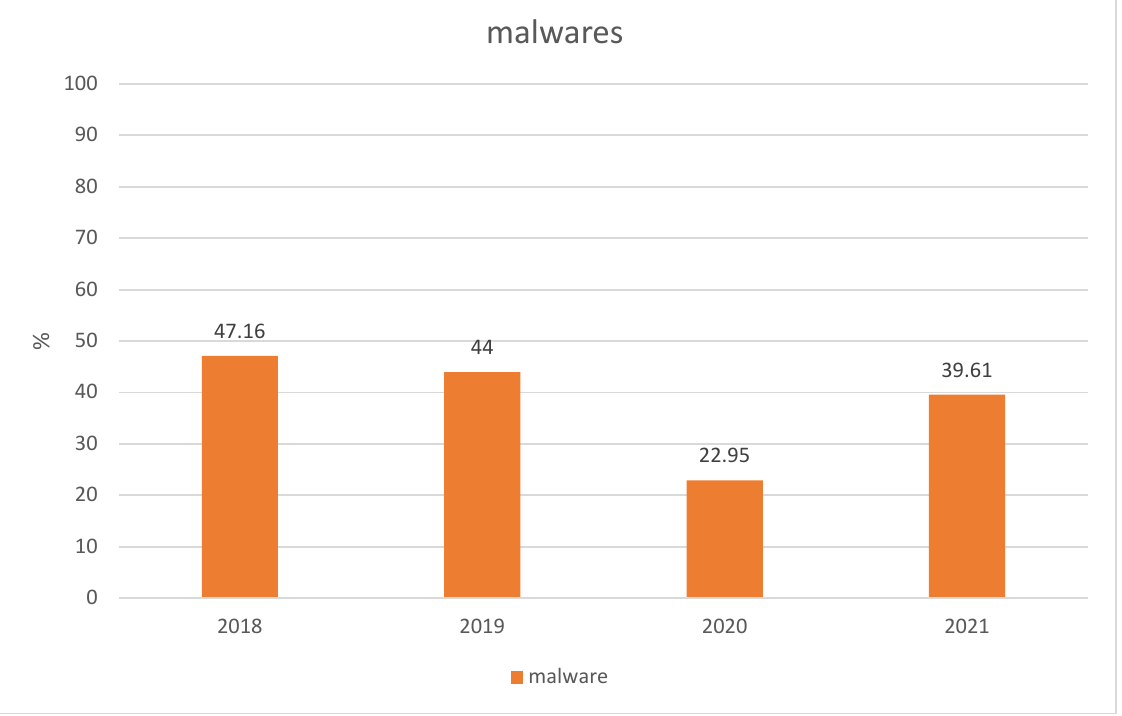
Figure 1. Malware threats to ICSs over the last four years.